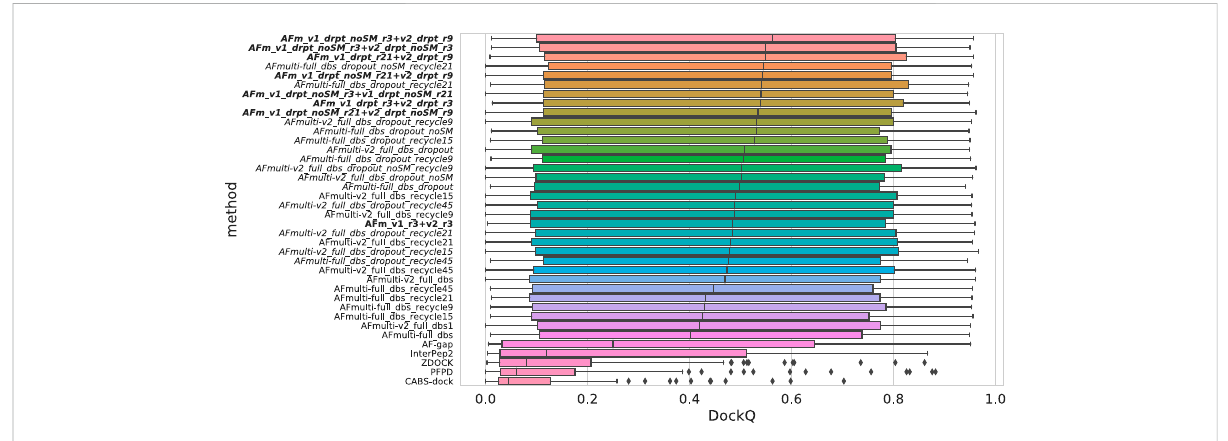
FIGURE 6 Distributions of DockQ scores for fi nal selected predictions for each target from each method. Variations on AlphaFold-Multimer version 2.2.0aremarkedinitalicswhilecombinationsofversions2.1.0and2.2.0aremarkedinboldwith full_dbs removedsinceitisusedinallmethods. The abbreviations drpt and r stand for dropout and recycles , respectively. The color is a gradient based on the rank of the median